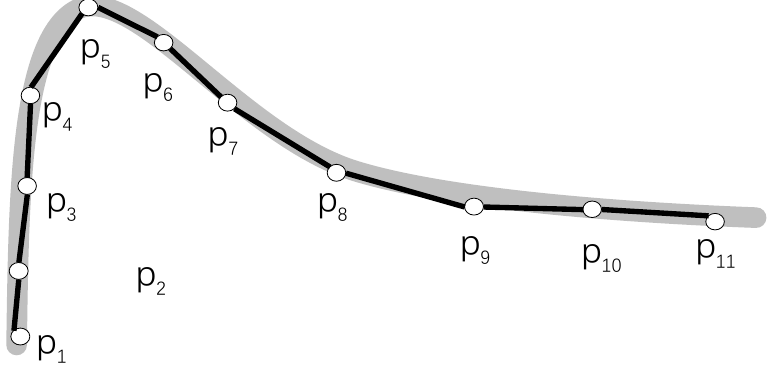
Figure 11. Interpolation results for all connecting segments.